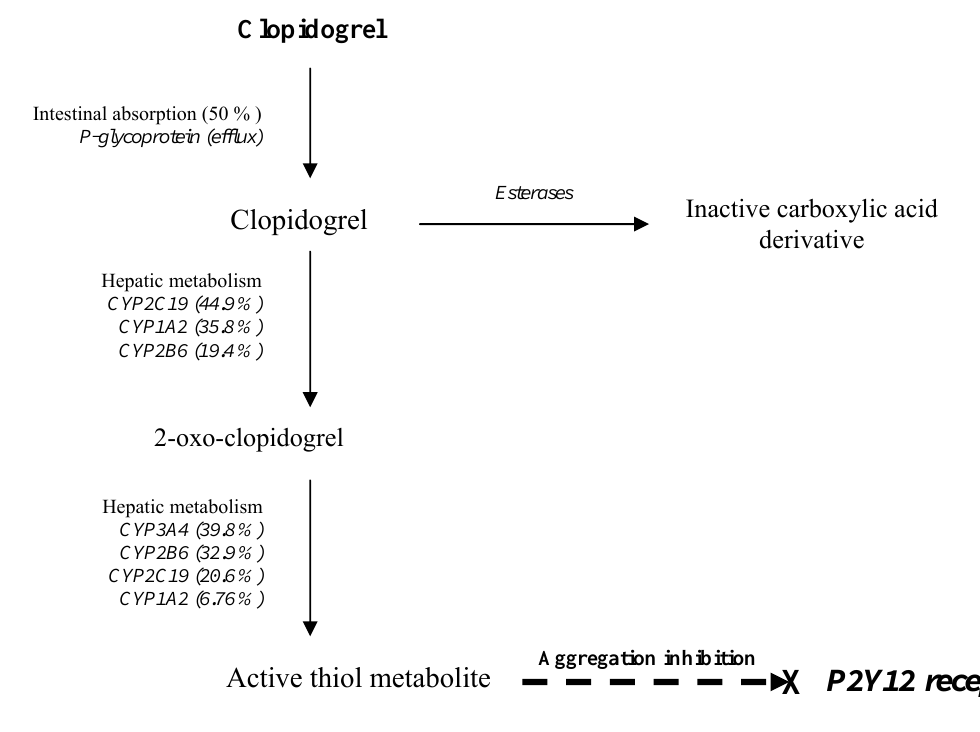
Figure 1. Pharmacokinetic and pharmacodynamic pathways involved in clopidogrel